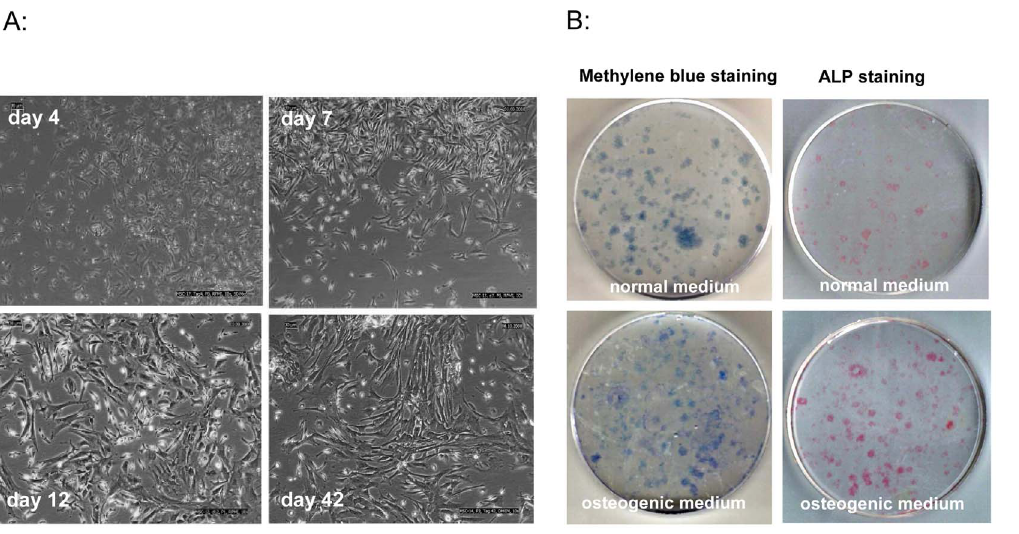
Figure 5. MSC characterization. A: MSCs were evaluated under a light microscope and representative photographs were captured on days 4, 7, 12, and 42 of incubation. Cells show typical fibroblast morphology and undergo typical time-dependent transitions among three morphologically distinct cell types: thin spindle-shaped cells, wider spindle-shaped cells, and still wider spindle-shaped cells. B: Fibroblastic colony-forming unit assays (CFU-F) were performed for 14 days. Colonies were then stained for ALP and methylene blue. When cultivated in normal medium, only a few colonies expressed ALP (line 1), whereas nearly all of the colonies stained with methylene blue also showed ALP expression when cultivated in osteogenic medium (line